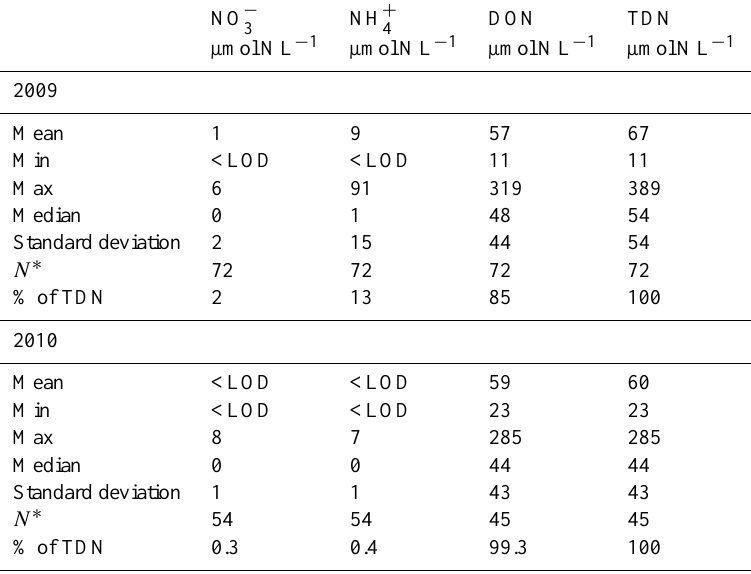
Table 2. Statistics of annual concentrations of NH + samples collected from dip wells over the 2-year period. N ∗ indicates the number of samples